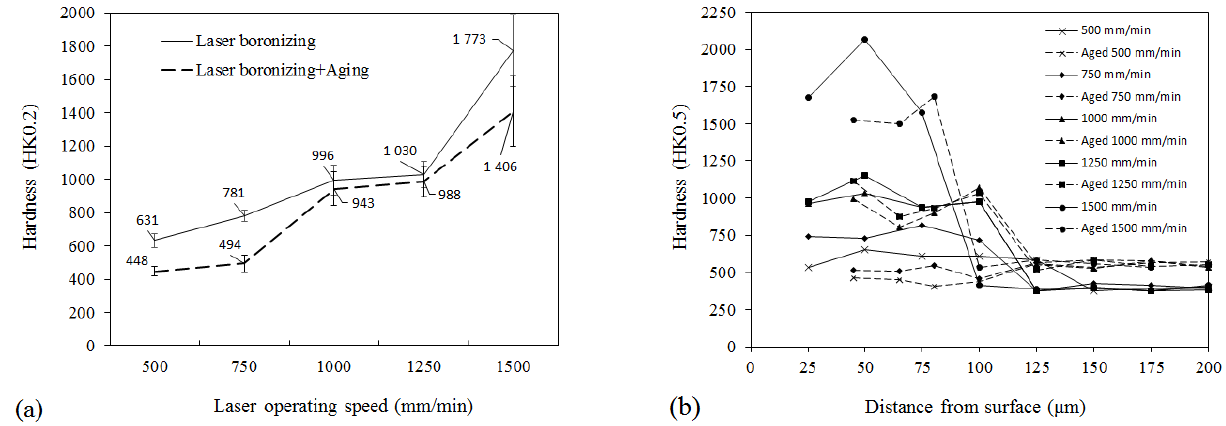
Figure 14. Average hardness of laser-boronized layers ( a ) and hardness depth profiles ( b ) before and after aging.